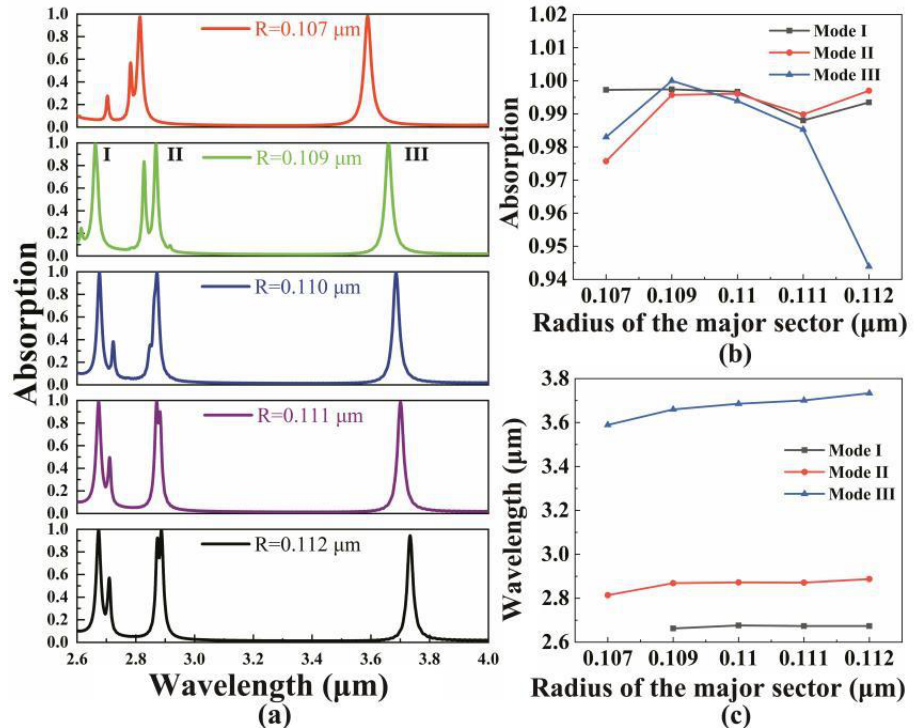
Figure 6. ( a ) Absorption changing curves of the radius r of a large sector changing from 0.107 to 0.112 μm by fixing the radius of the small sector at 0.08 μm. ( b ) An absorption line chart of three resonant modes as R increases. ( c ) A wavelength line chart of three resonant modes as R increases. The wavelengths in three modes, I – III, are only slightly blue- shifted 0.03 μm under the influence of the local electromagnetic field. This is because with the increase in the radius of the small sector, the effective arc length of the small sector increases, which weakens the local charge capacity of the minor sector. In this case, the coupling between different sectors is reduced, weakening the absorption efficiency. As mentioned above (mode III in Figure 3), the electromagnetic field of mode III is mainly localized in the arc segment of the major sector. Therefore, according to Figure 6a – c, when the radius of a major sector varies from 0.109 to 0.112 μm (when R is 0.107 μm, mode I is not within the range of mid-infrared band), the resonance absorption efficiencies of modes I and II